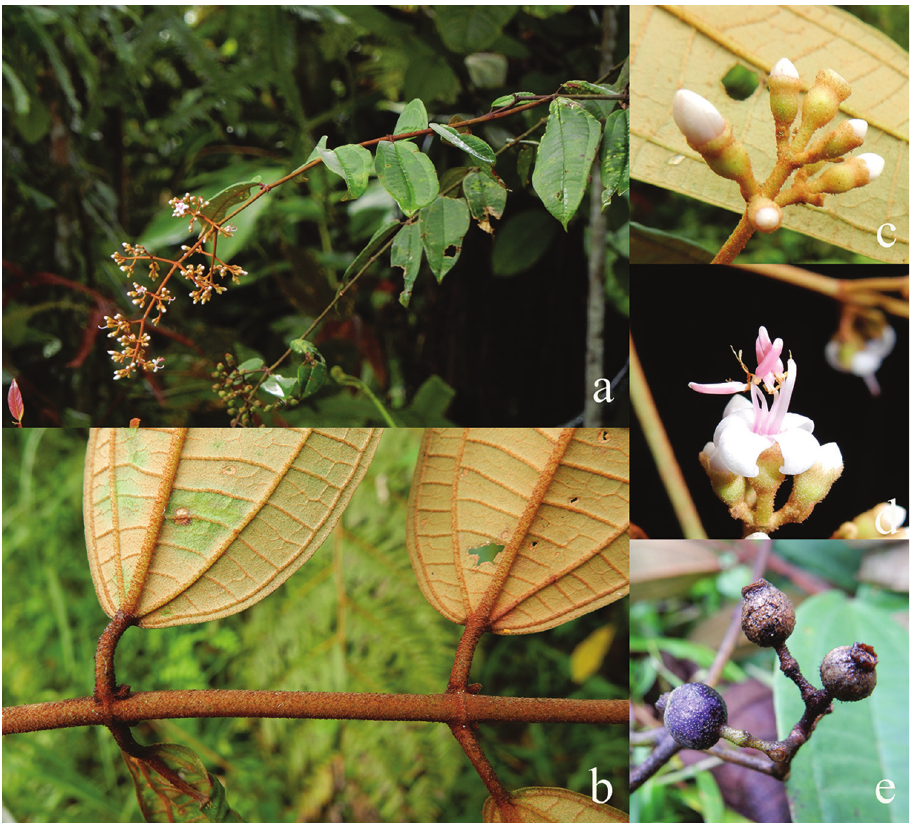
Figure 7. Dissochaeta biligulata a habit b branchlet c hypanthium d flower e fruits. Photographs by D. Penneys; vouchers: Penneys 2488 (WNC) & Penneys 2509